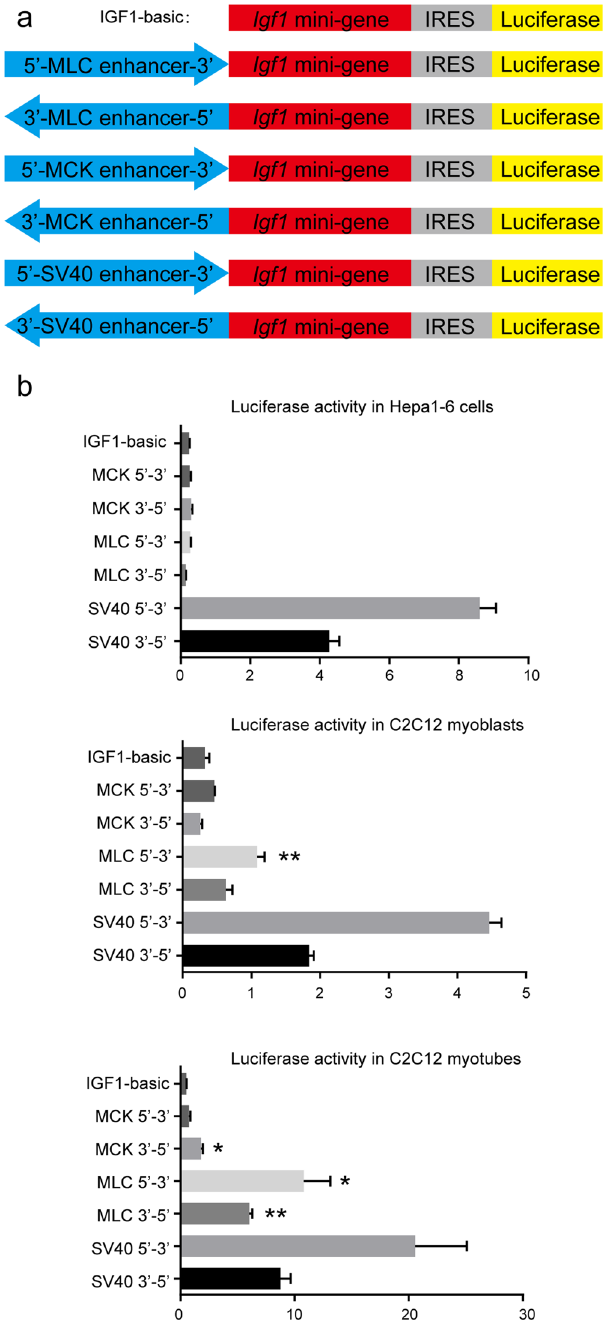
Figure 1. Confirmation of the activity of candidate enhancers by luciferase assays. (a ) A schematic of luciferase reporter vectors. The enhancer sequences are linked to the Igf1 mini-gene in both orientations. The yellow, grey, and red blocks represent the luciferase coding cassette, the IRES element, and the Igf1 mini-gene cassette, respectively. The blue arrows represent the enhancer sequences and indicate the orientation with respect to the Igf1 mini-gene. (b) The luciferase expression levels of the indicated constructs in Hepa1–6 cells (top), C2C12 myoblasts (middle), and C2C12 myotubes (bottom). The results are representative of three independent experiments. Bars represent the mean values, and the error bars represent the standard error of the mean (SEM). * P < 0.05 between indicated reporter vectors and the IGF1-basic construct; ** P < 0.01 between indicated reporter vectors and the IGF1-basic construct. Statistical significances were analysed by Student’s